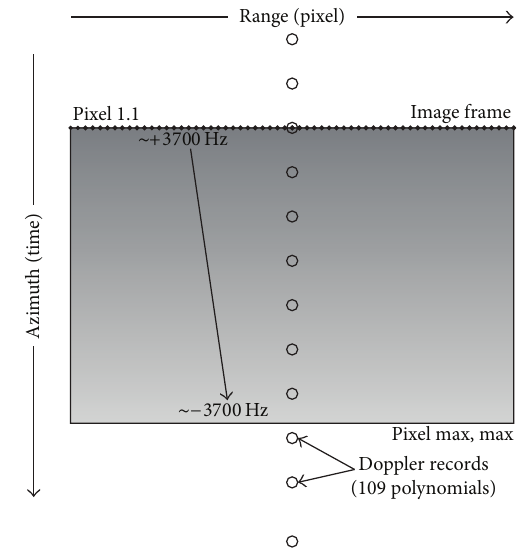
Figure 6: General processing flow chart. Two options: implementa- tion in DORIS shifting the kernel (left); external scripts in MATLAB to set the image spectrum to zero (right).